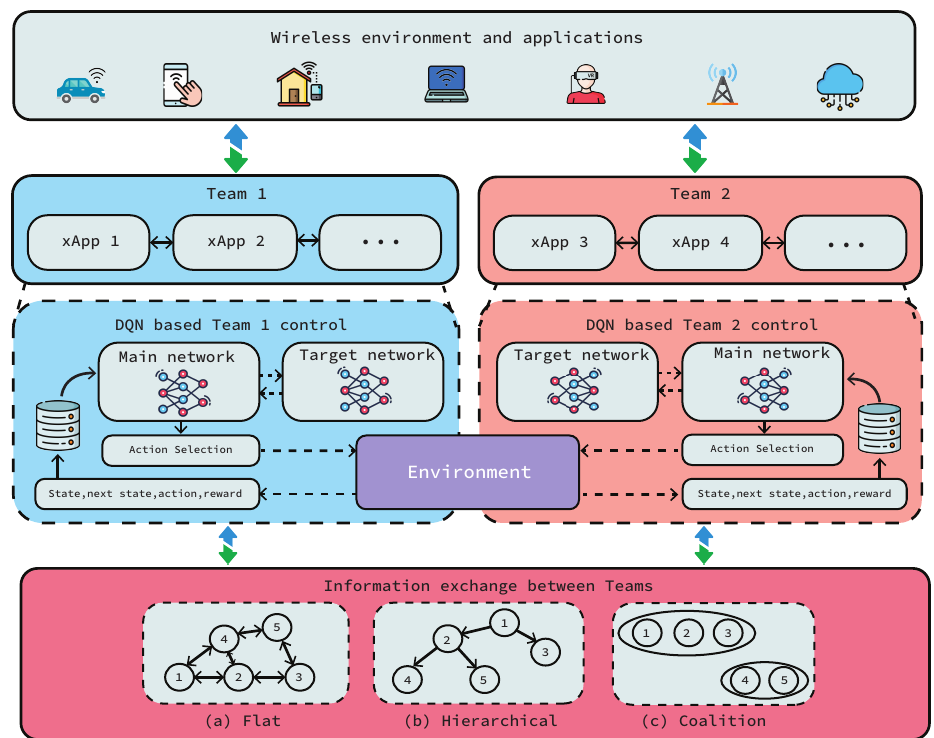
Figure 2. Multi-agent team learning: The figure shows two teams comprised of more than one xApp where each xApp is a DQN agent that interacts with the environment. Teams can form different communication structures to share information: ( a ) flat, ( b ) hierarchical and ( c ) coalition. In our case study, we consider the interactions of one team of